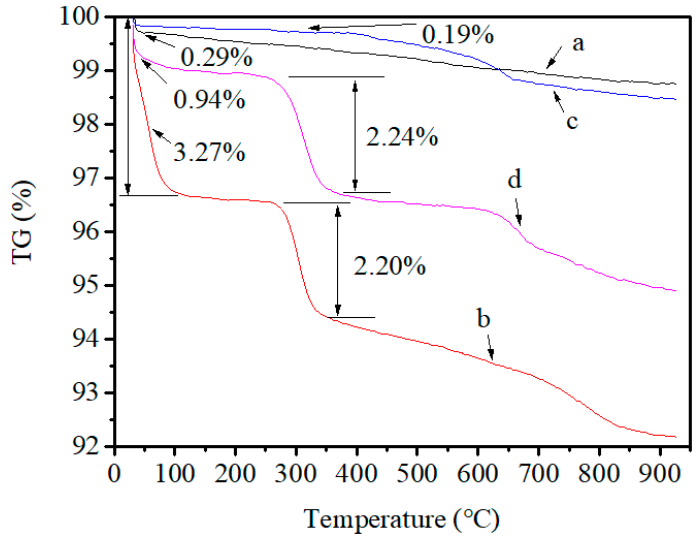
Figure 13. TG curves for ( a ) sample A; ( b ) the mixture of sample A, binder and water; ( c ) sample B; ( d ) the mixture of sample B, binder and water during the heating process.